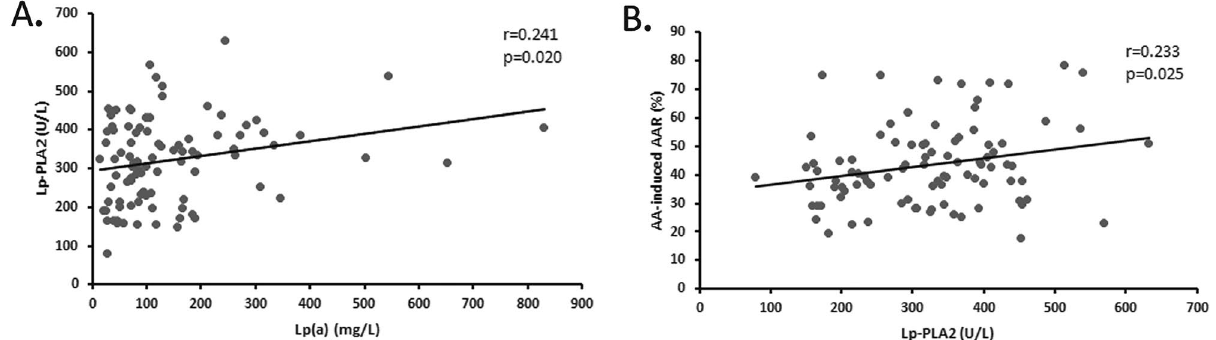
Figure 4. Association between plasma Lp-PLA2 and Lp(a) levels/AA-induced platelet average aggregation rate in subjects. ( A ) Univariate linear correlation analysis of serum Lp(a) levels with Lp-PLA2 activities. ( B ) Univariate linear correlation analysis of the serum Lp-PLA2 activities with AA-induced platelet average aggregation rate (AAR).